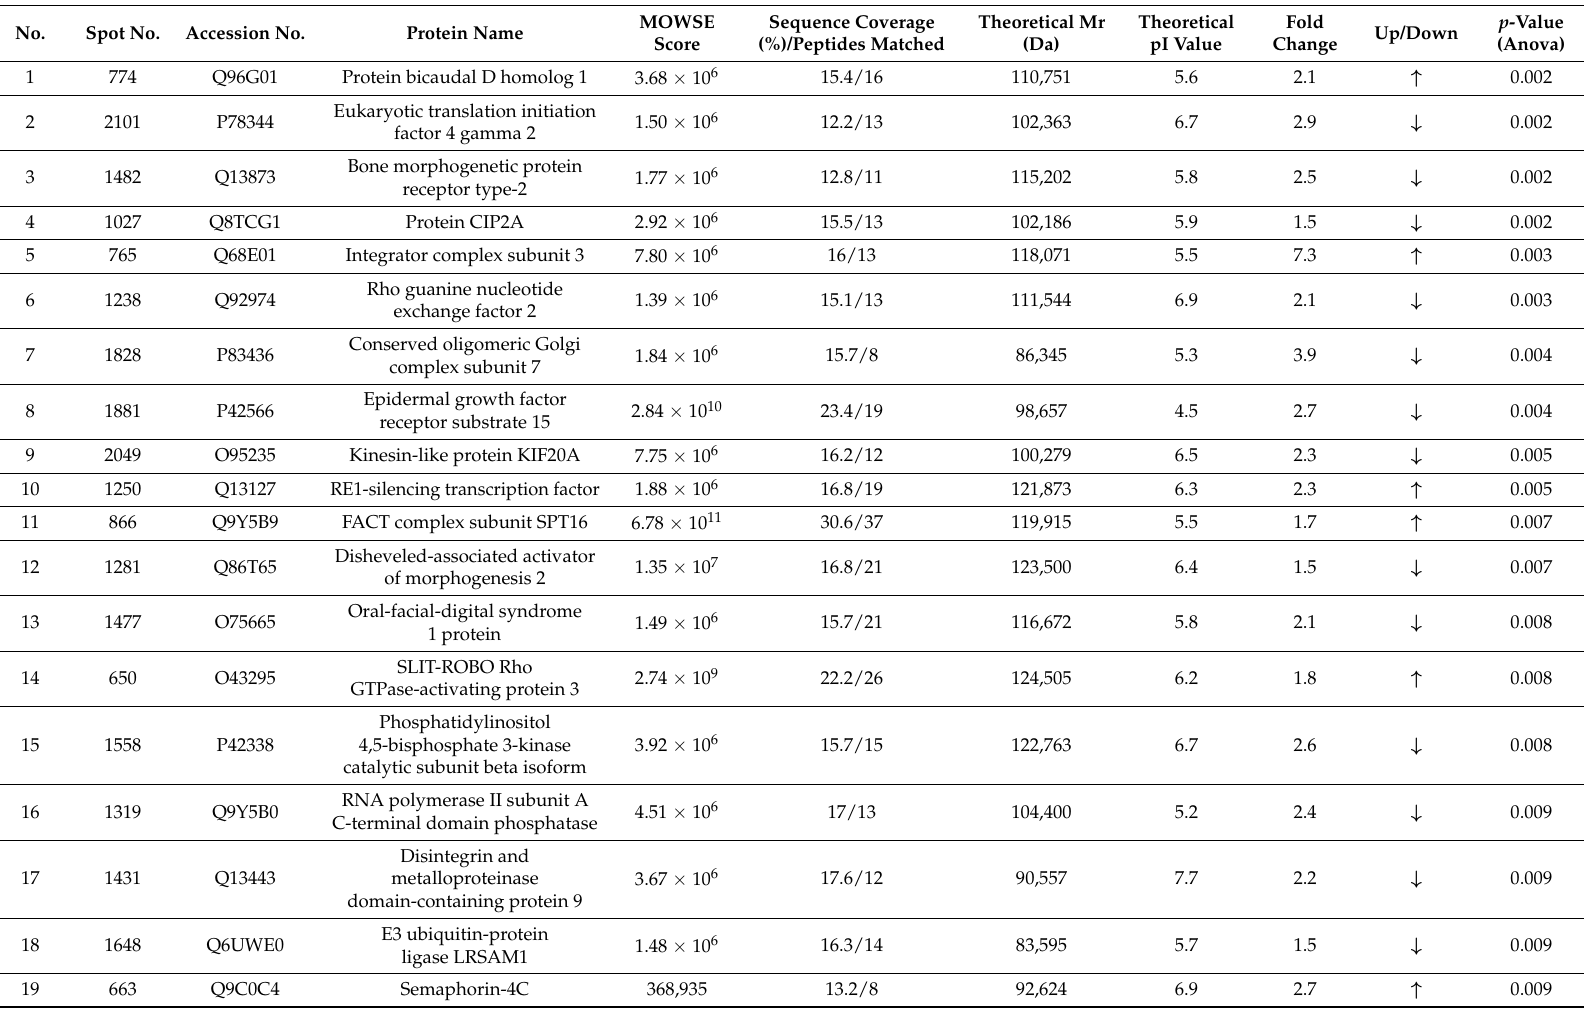
Table 2. List of differentially expressed proteins in MKN28 cells treated with PEC, identified using MALDI-TOF/TOF-MS analysis.